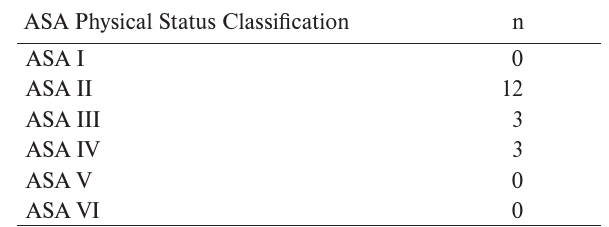
Table 2. Preoperative ASA classification of the